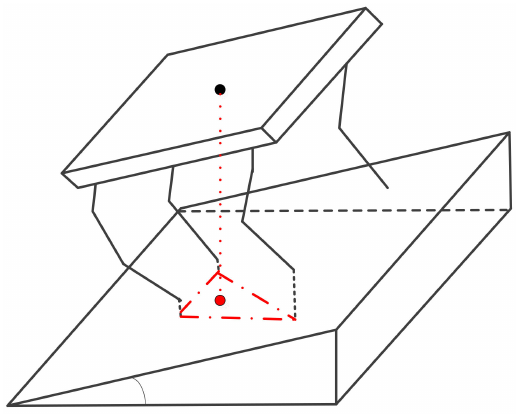
Figure 4. Figure showing the projection point of the robot foot on the